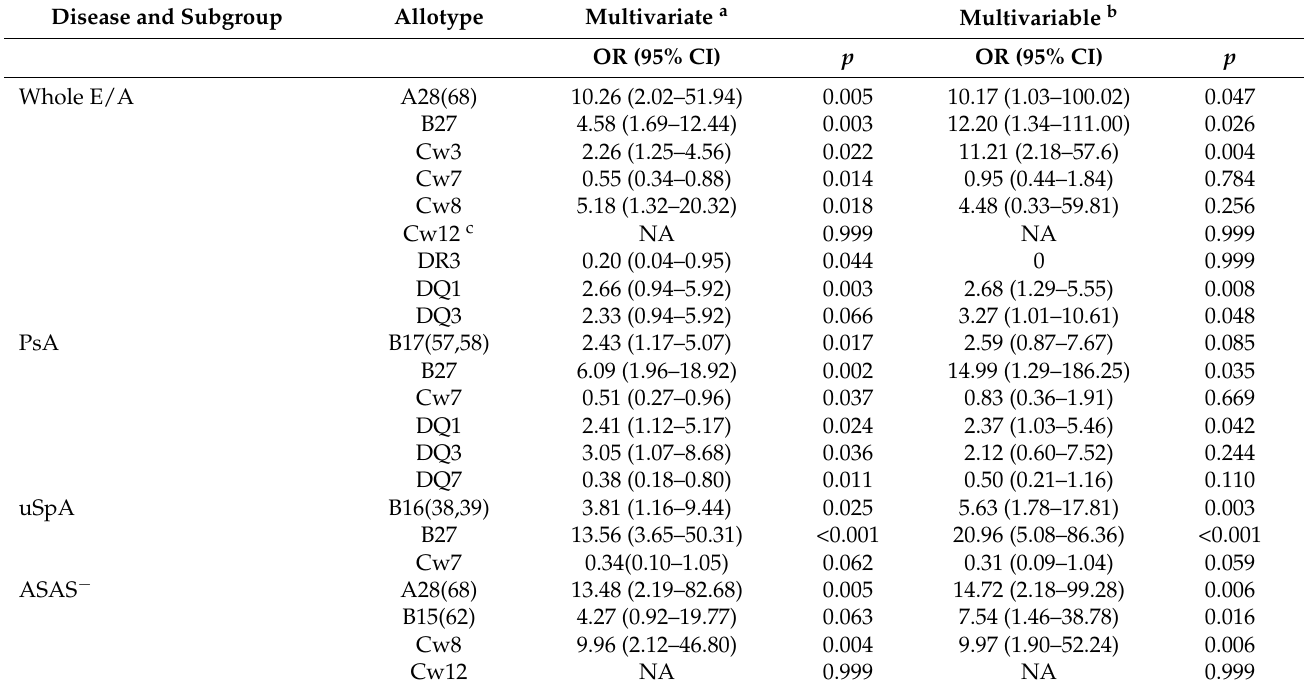
Table 5. Logistic regression analyses to assess the interdependency of variables found to be statistically associated with peripheral seronegative enthesitis/arthritis (E/A) in the whole cohort or clinical subgroups (odds ratio; OR > 1), as compared to healthy donors